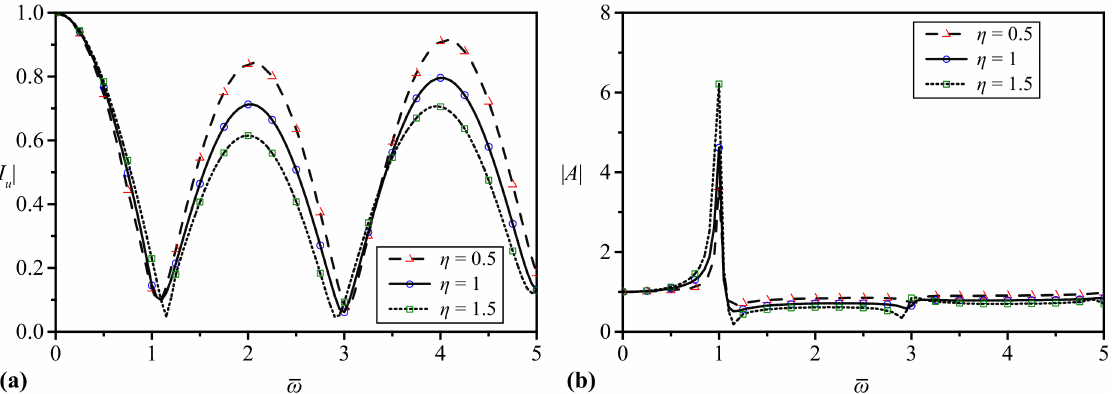
Figure 4. The effects ofs the disturbance degree ( η ) on the kinematic response and amplification factors of piles ( ρ p = 2500 kg/m 3 , E p = 36 GPa, r 0 = 0.5, υ j = 0.4, β j = 0.2, G N +1 = 36 MPa, H = 20 m, (cid:52) r = 0.2 m). ( a ) Kinematic response factor; ( b ) Amplification